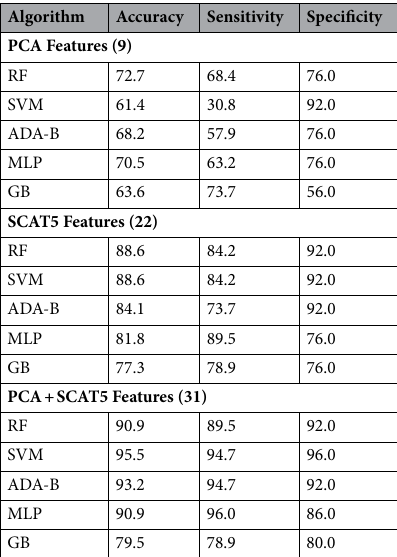
Table 4. Concussion classification evaluation metrics for the three different feature selections proposed: a. The 9 PCA features; b. the 22 SCAT5 features; c. the 31 combined features of PCA and SCAT5.